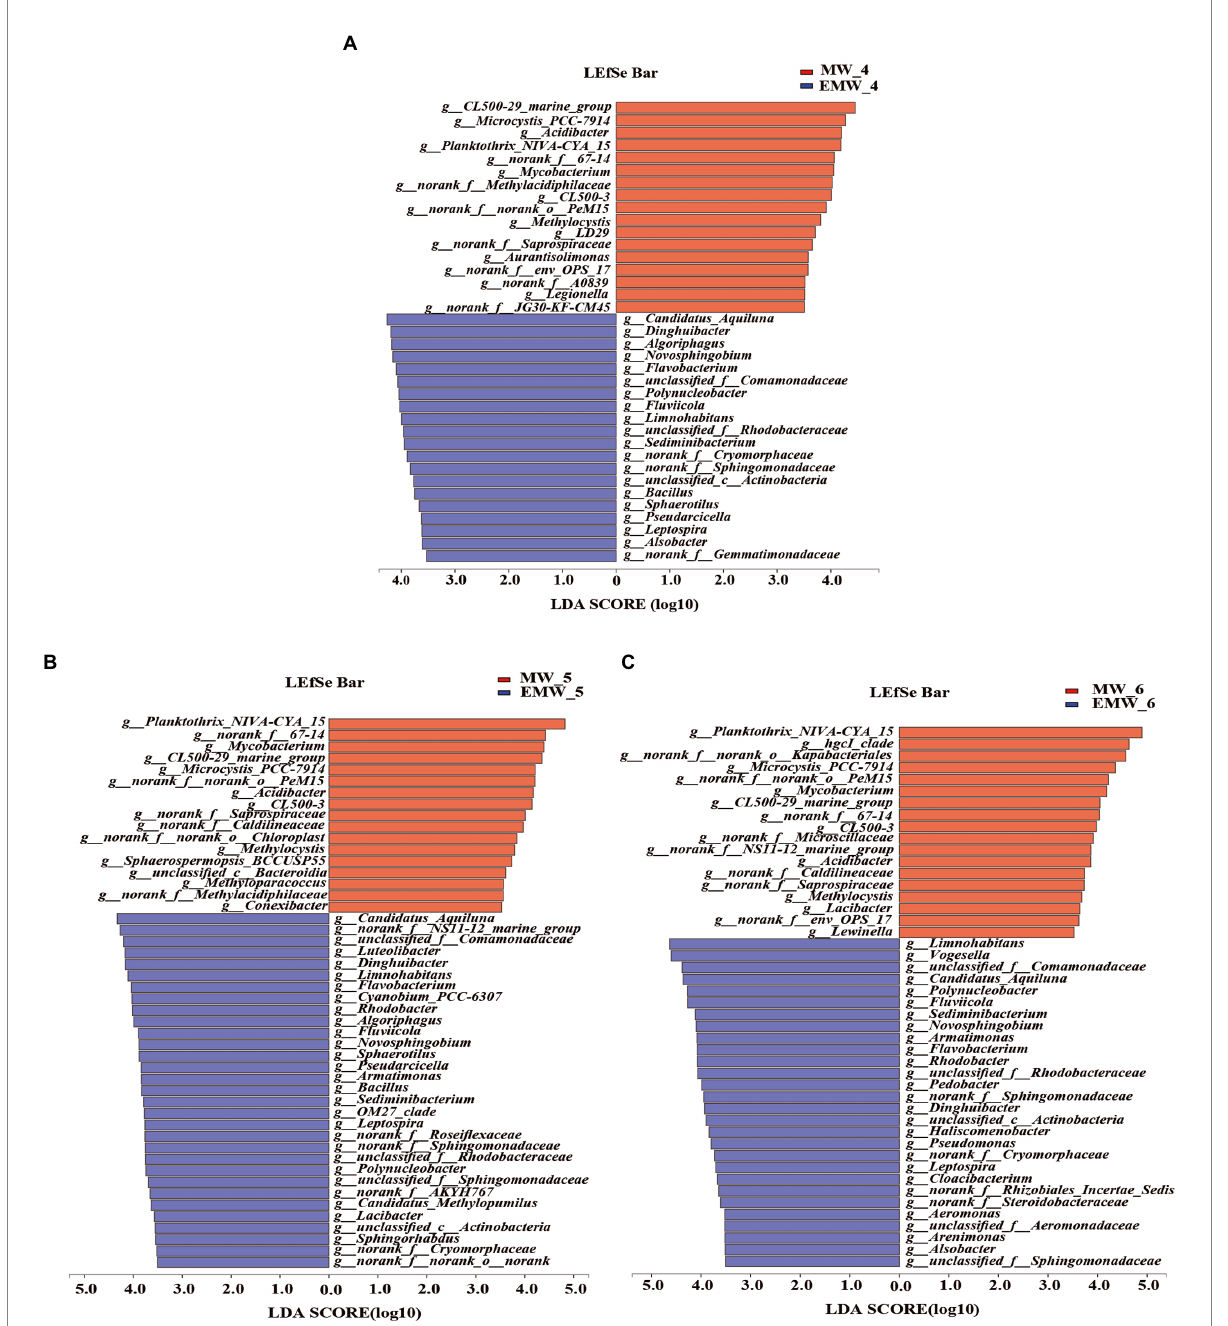
FIGURE 7 Microbial community analysis at the genus level. Effect size (LEfSe) analyses on days 30(7A), 60(7B), and 90(7C). For taxa, which were defined as unclassified, norank, the name of a higher taxon level was added before its taxon abbreviation (c, class; o, order; f,